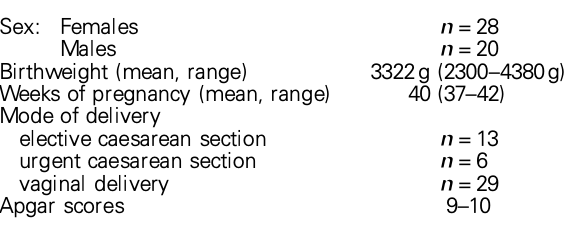
Table 1. Clinical characteristics of the studied neonates Sex: Females n = 28